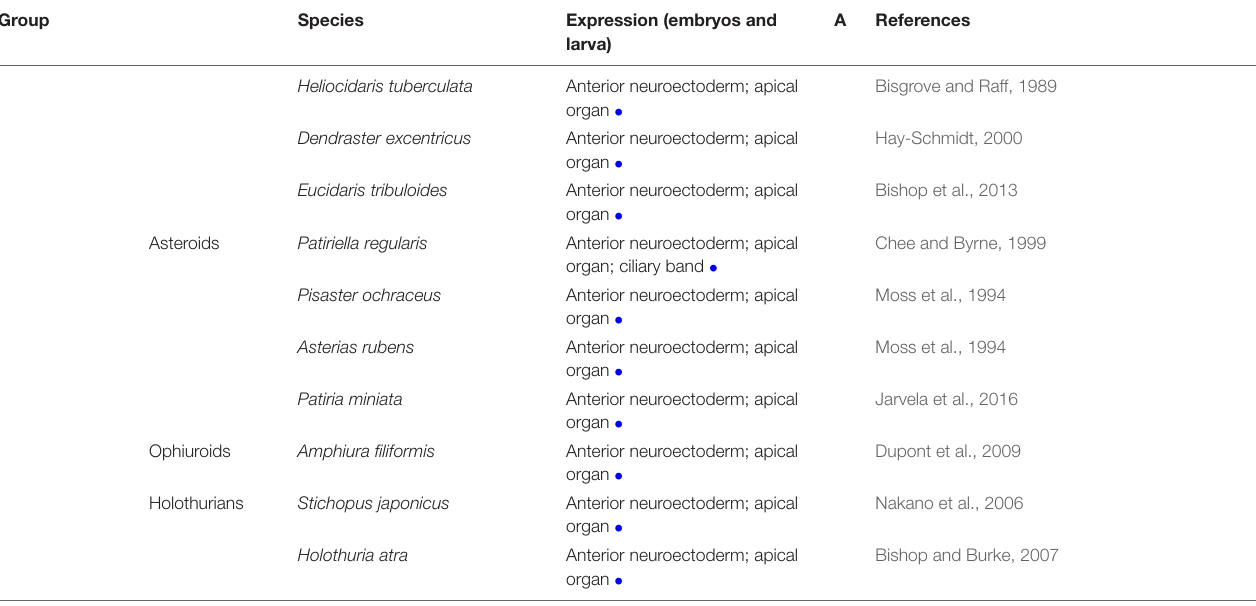
TABLE 2B | (B) Indolamines: melatonin and histamine distribution in embryos or adult tunicates, cephalochordates, and echinoderms. Neurotransmitter Indolamines